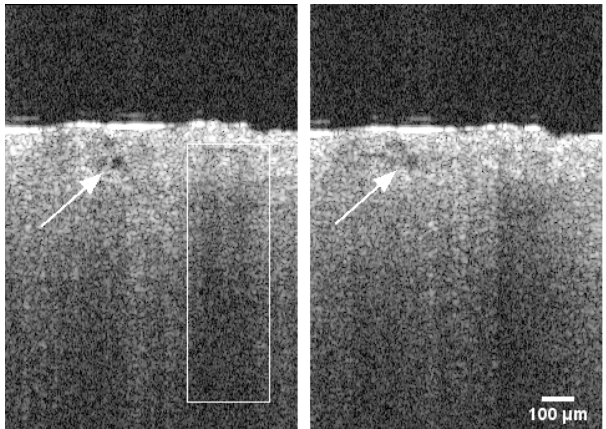
Fig. 7. E®ect of GNRs presence inside a lymphatic °uid on OCT signal. There is a strong signal rise after the injection of GNRs (right panel) due to increased scattering from within the lymphatic vessel. The lymphatic vessel is marked by an arrow; blood vessel is marked by the white rectangle.